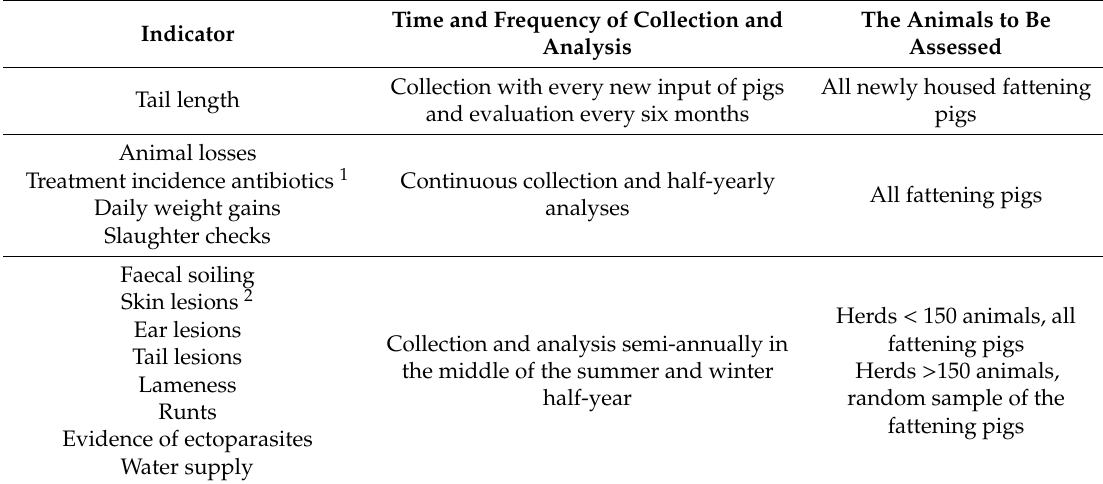
which indicators should be collected for which animals, when and how often (according to